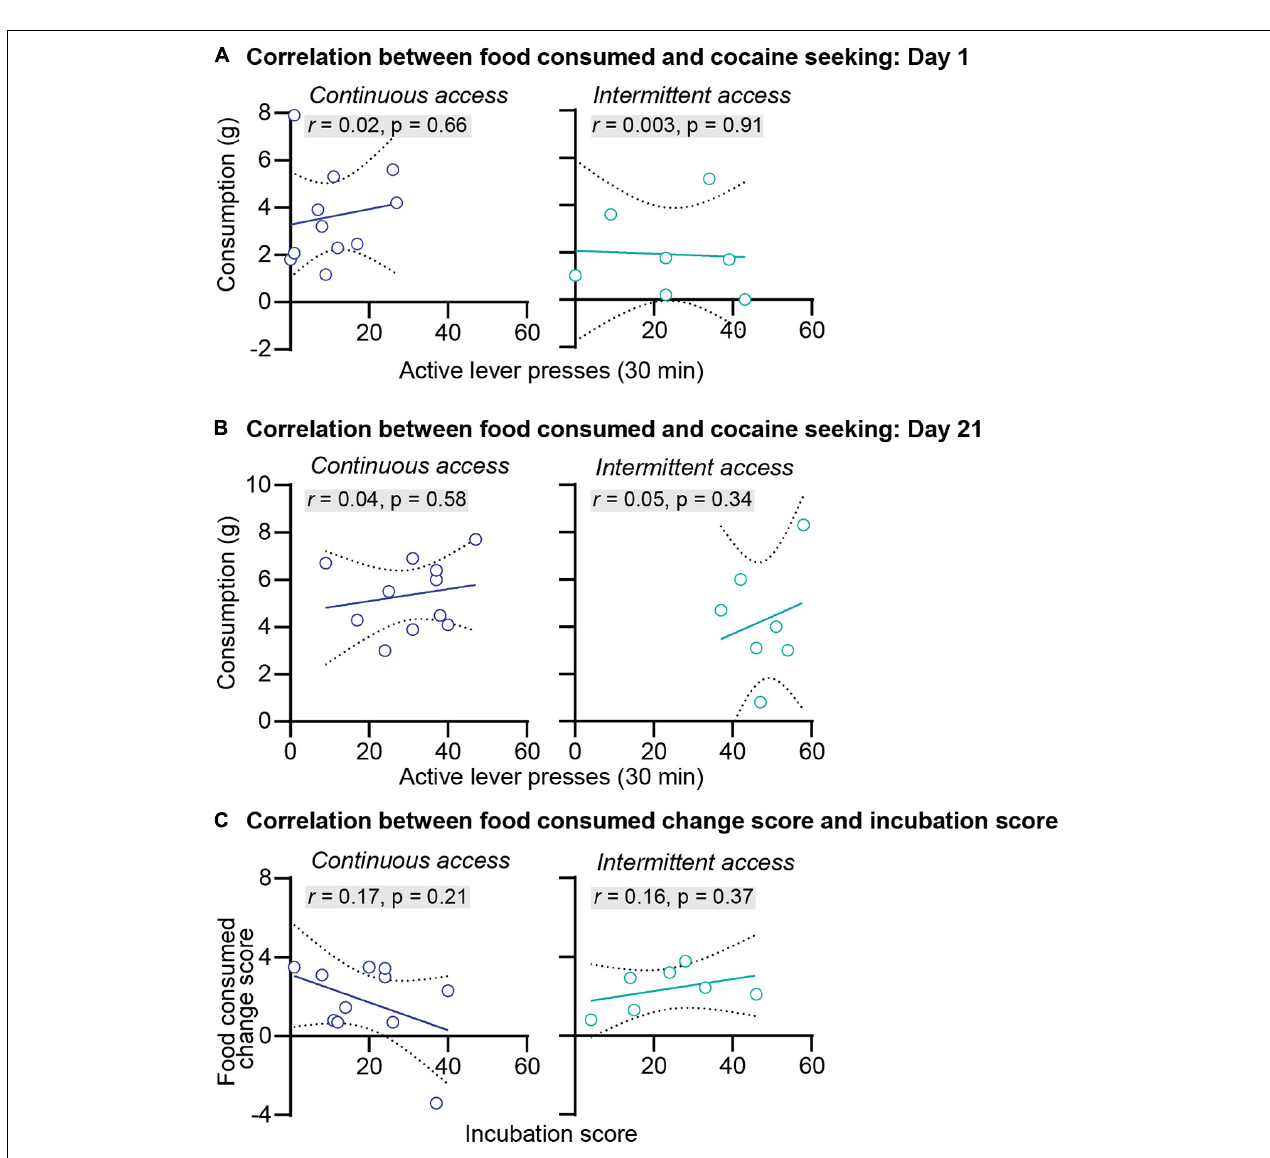
FIGURE 3 | Correlations between the food consumed and incubation of cocaine craving. (A) Correlations between the amount of food consumed in grams and the number of active lever press during relapse test on abstinence day 1 after continuous (left) and intermittent (right) self-administration (continuous access n = 11, intermittent access n = 7). (B) Correlations between the amount of food consumed in grams and the number of active lever press during relapse test on abstinence day 21 after continuous (left) and intermittent (right) self-administration (continuous access n = 11, intermittent access n = 7). (C) Correlations between the food consumed change score (grams of food consumed on abstinence day 21 minus grams of food consumed on abstinence day 1) with the incubation score (active lever presses on abstinence day 21 minus active lever presses on day 1) after continuous (left) and intermittent (right) cocaine self-administration (continuous access n = 11, intermittent access n =